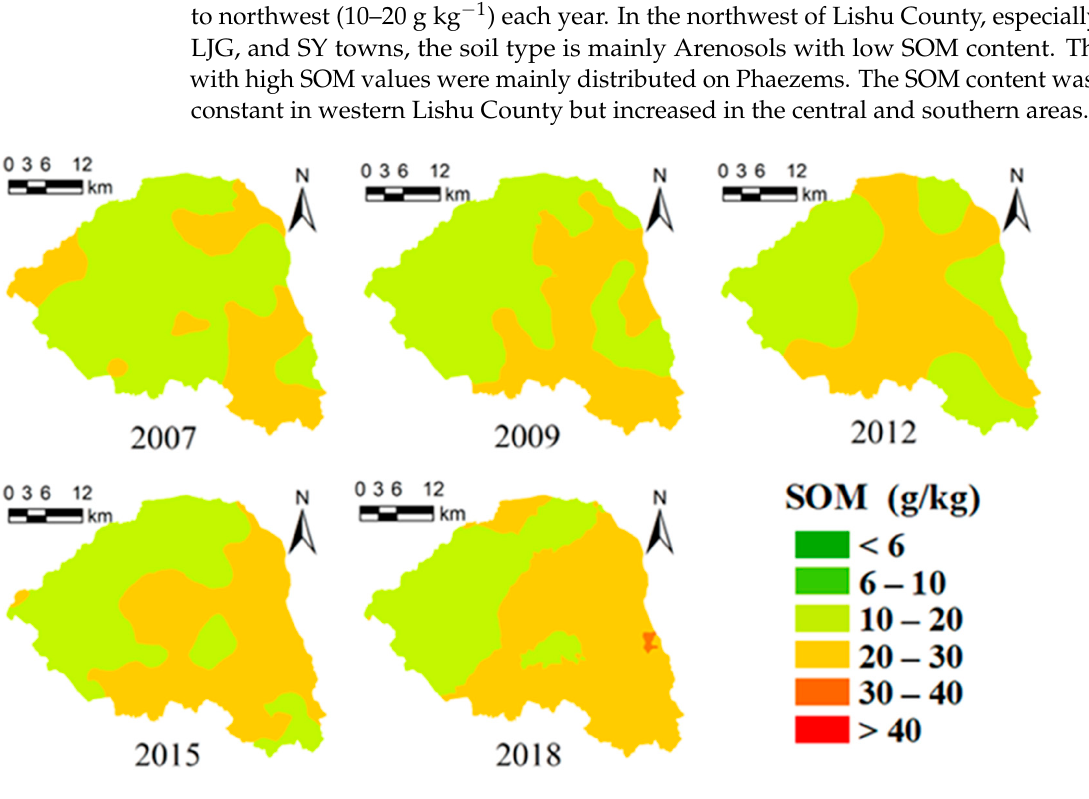
Figure 4. Spatial distribution maps of soil organic matter (SOM) content in 2007, 2009, 2012, 2015, and 2018 in Lishu County.